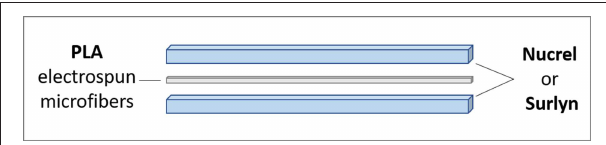
FIGURE 1 | Schematic representation of the sandwich-type